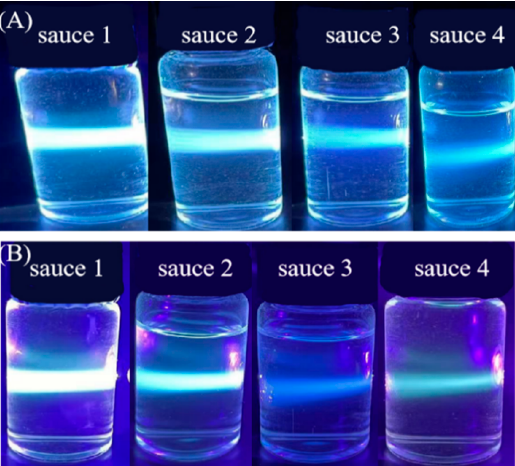
Figure 3. Sample experimental phenomena at ( A ) 365 nm and ( B ) 395 nm wavelength.